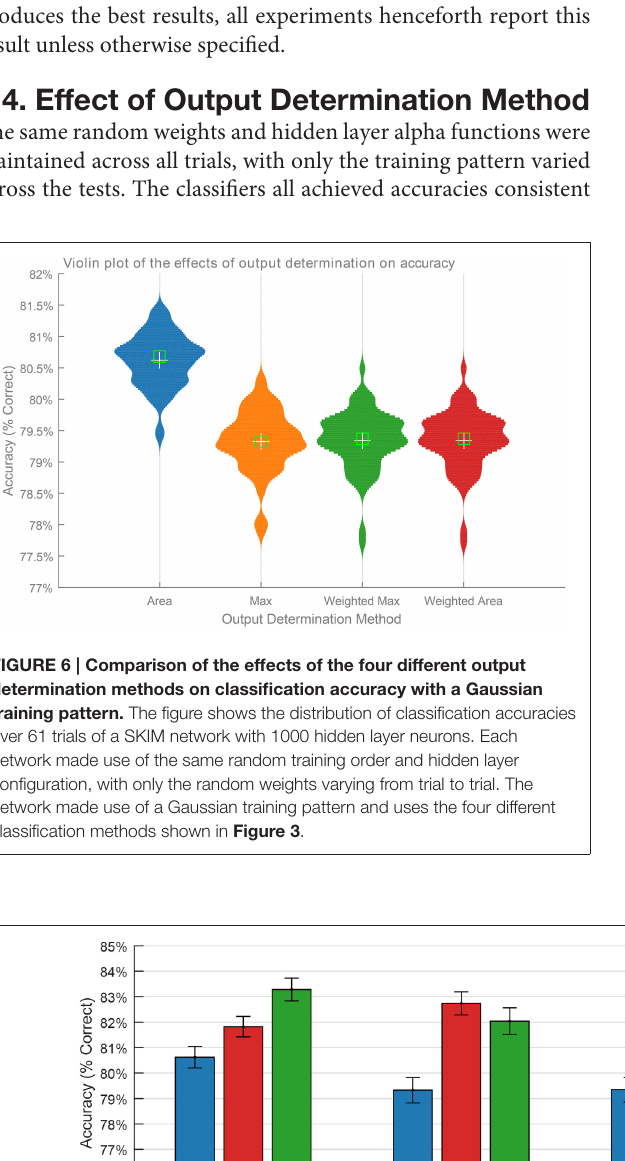
Frontiers in Neuroscience |